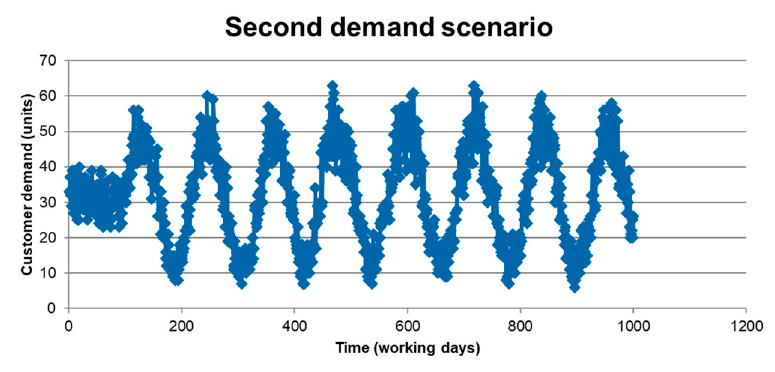
Figure 7. Second demand scenario—feasible scenario (own elaboration).